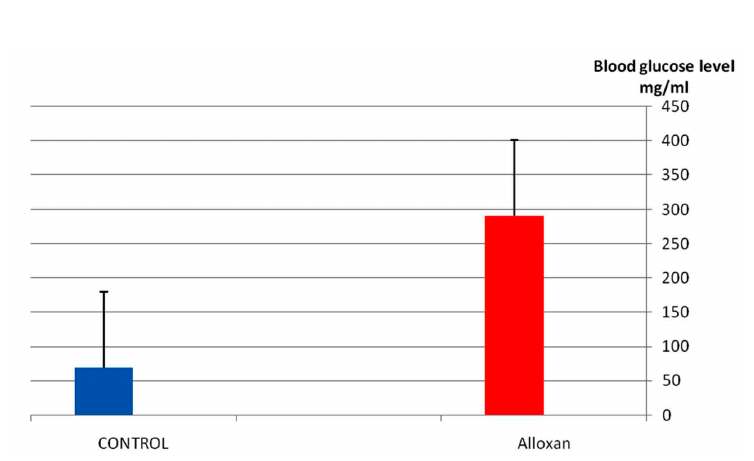
Fig. 1. Effect of alloxan in blood glucose level of laboratory rats n=5